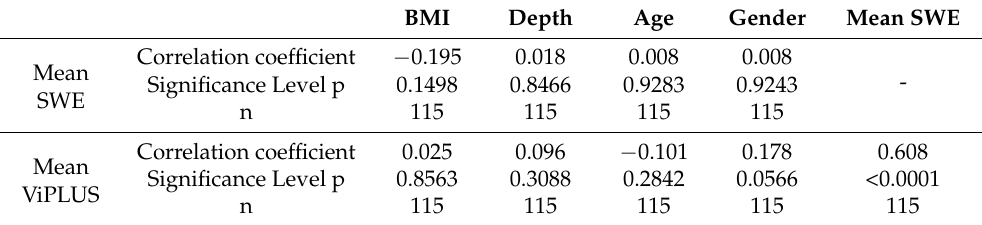
Table 4. Correlations between 2D SWE, the respective Vi PLUS measurements and patient or meas- urement characteristics.